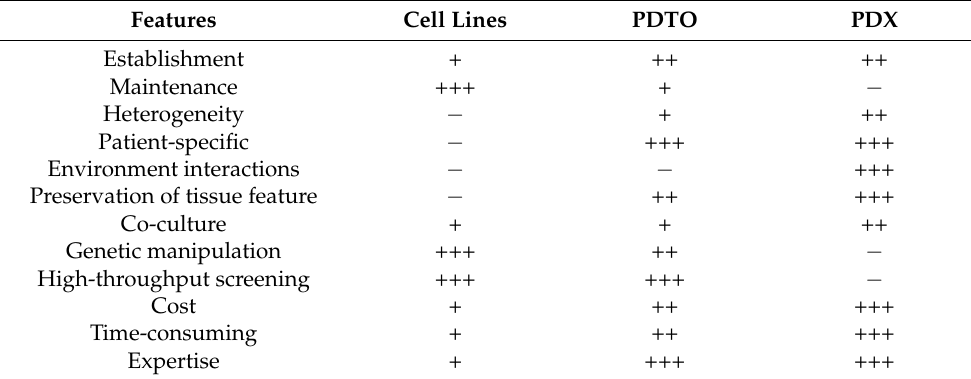
Table 5. Comparison between cell lines, PDTO models and PDX models.